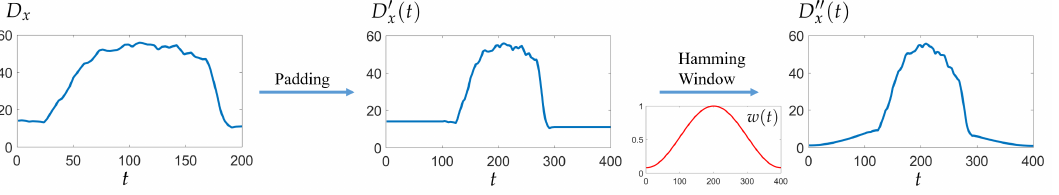
Figure 7. Visualization of the boundary padding and hamming window pre-processing before wavelet